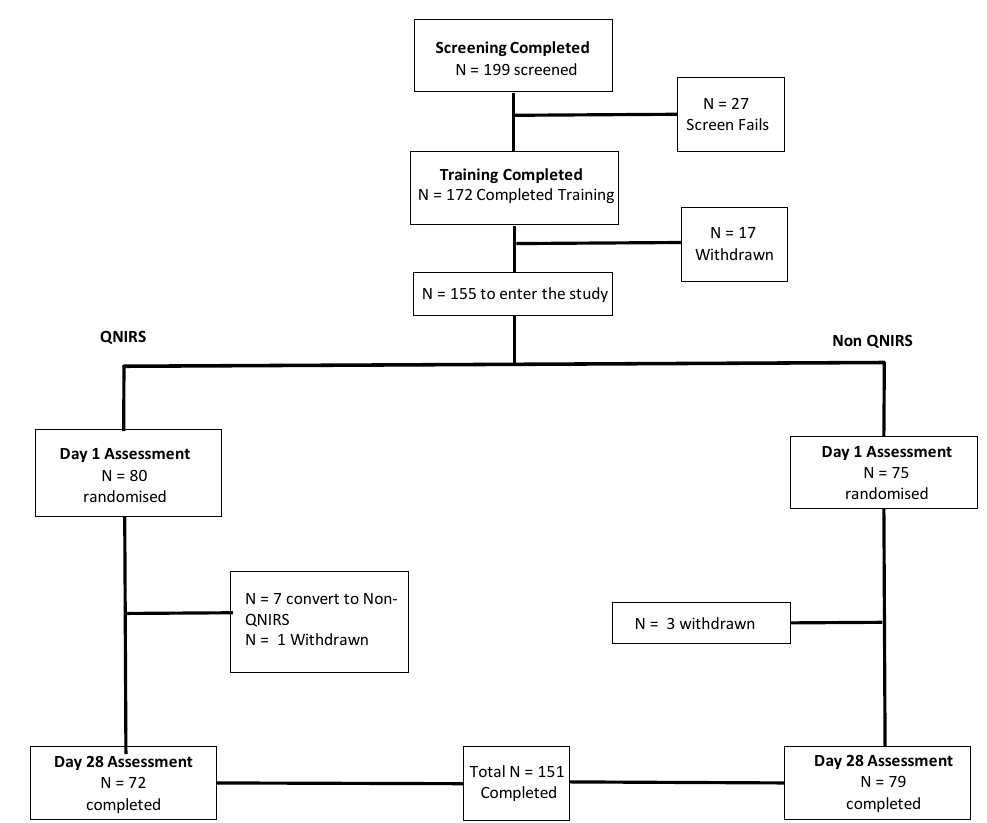
Figure 1. Participant disposition through the trial. Figure depicts the disposition of participants throughout the study, which culminating in N = 151 of the 155 who were randomised. A single participant in the placebo group withdrew due to adverse event (vomiting, which a follow-up reported had been remedied and the participant was in good health) and the remaining three withdrawals left due to other time commitments or lack of continued interest in the study. QNIRS, Quantitative Near-Infrared Spectroscopy.